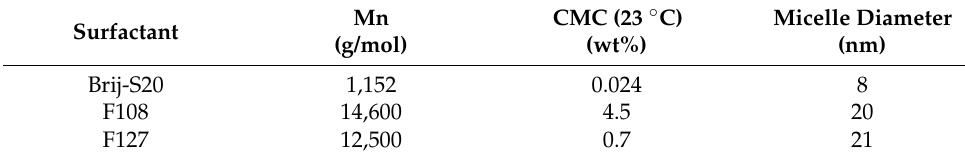
Table 2. Surfactant and Block copolymers properties